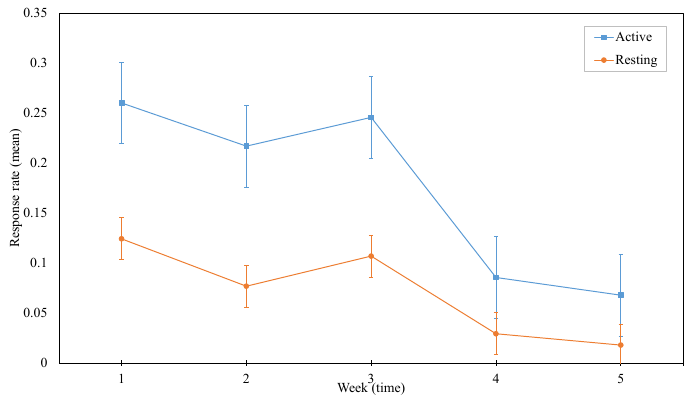
Figure 4. Comparison of response rates in treatment groups